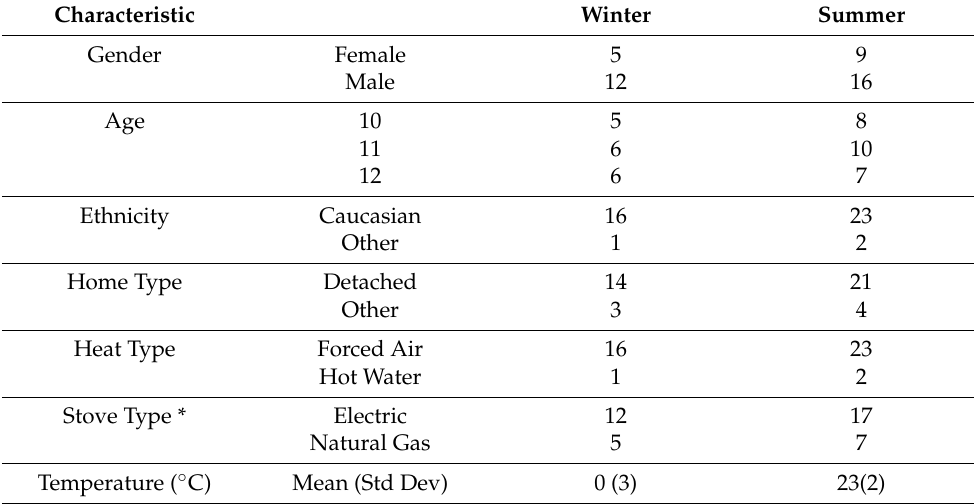
Table 1. Study participants characteristics.